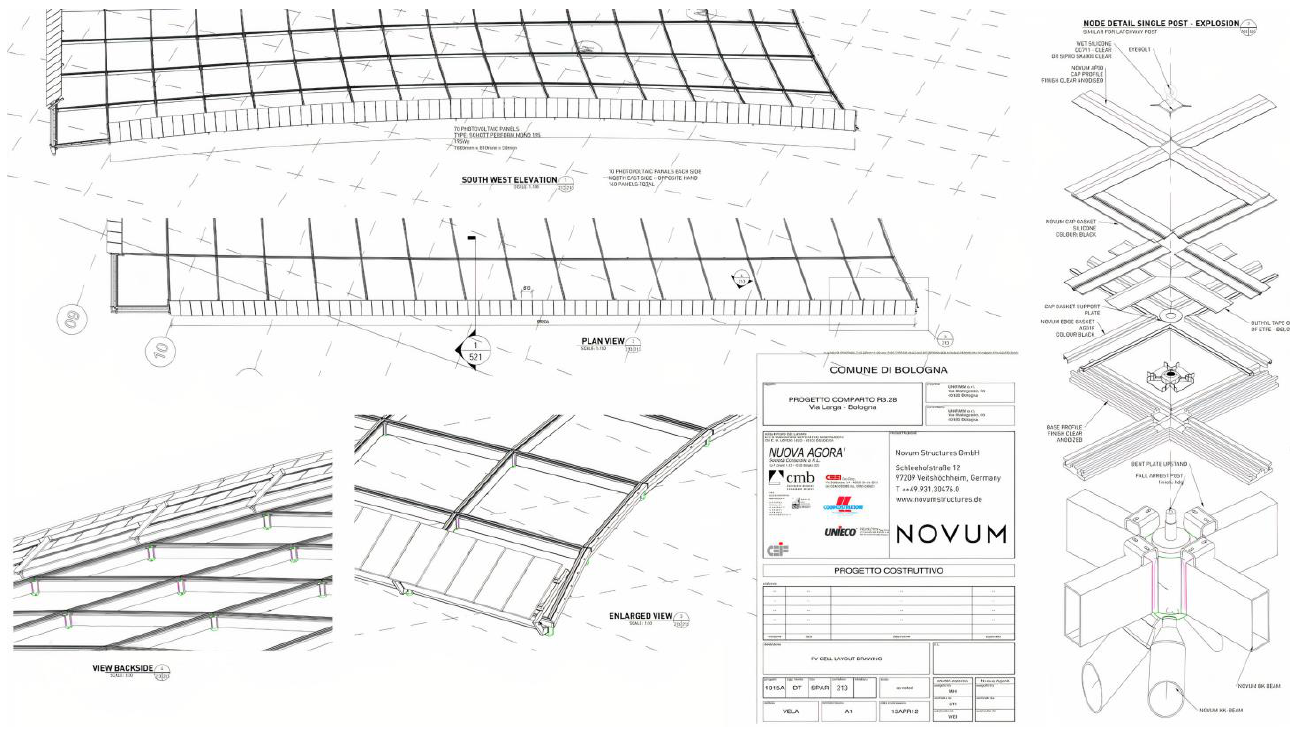
Figure 3. Original project panels of La Vela.